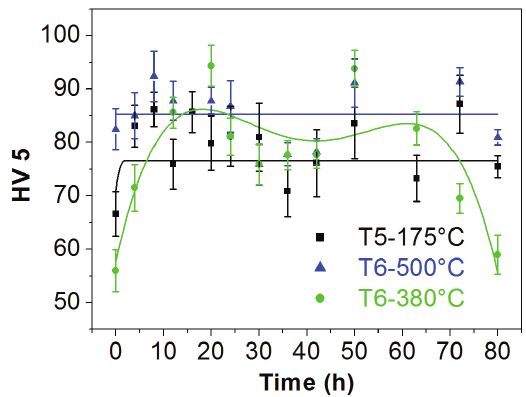
Figure 6. Hardness (HV5) as a function of heat treatment time for the ZK60-0.5wt.%RE alloy submitted to ageing treatment at various